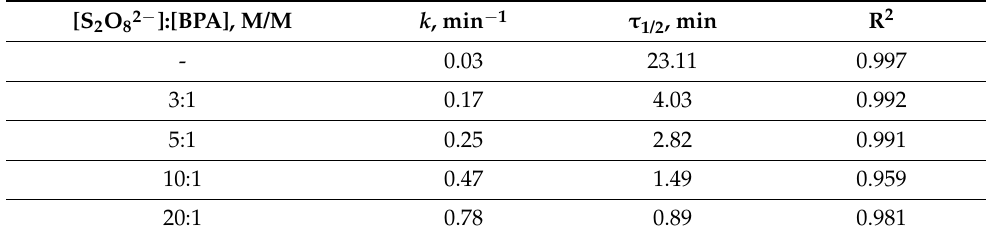
Figure 3. Kinetic curves for BPA degradation ( a ) and mineralization ( b ) in the UV/S 2 O 8 2 − system. [S 2 O 8 2 − ]/[BPA] (M/M) = 0 (curve 1), 3 (curve 2), 5 (curve 3), 10 (curve 4), 20 (curve 5). [BPA] 0 = 43.8 µ M, pH 0 = 5.7. Table 2. The effect of persulfate concentration (in terms of molar ratio of S 2 O 82– and BPA) on the kinetics of BPA degradation in the UV/S 2 O 82 −